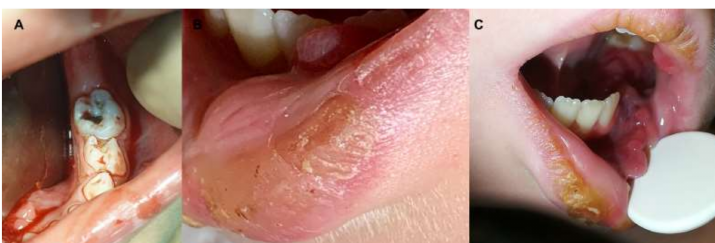
Figure 1. ( A ) Caries in the lower primary molars, intraoral bleeding, and gingival enlargement / hyperplasia. ( B ) Cracked lips and gingival enlargement. ( C ) Cracked lips, gingival enlargement / hyperplasia, and buccal